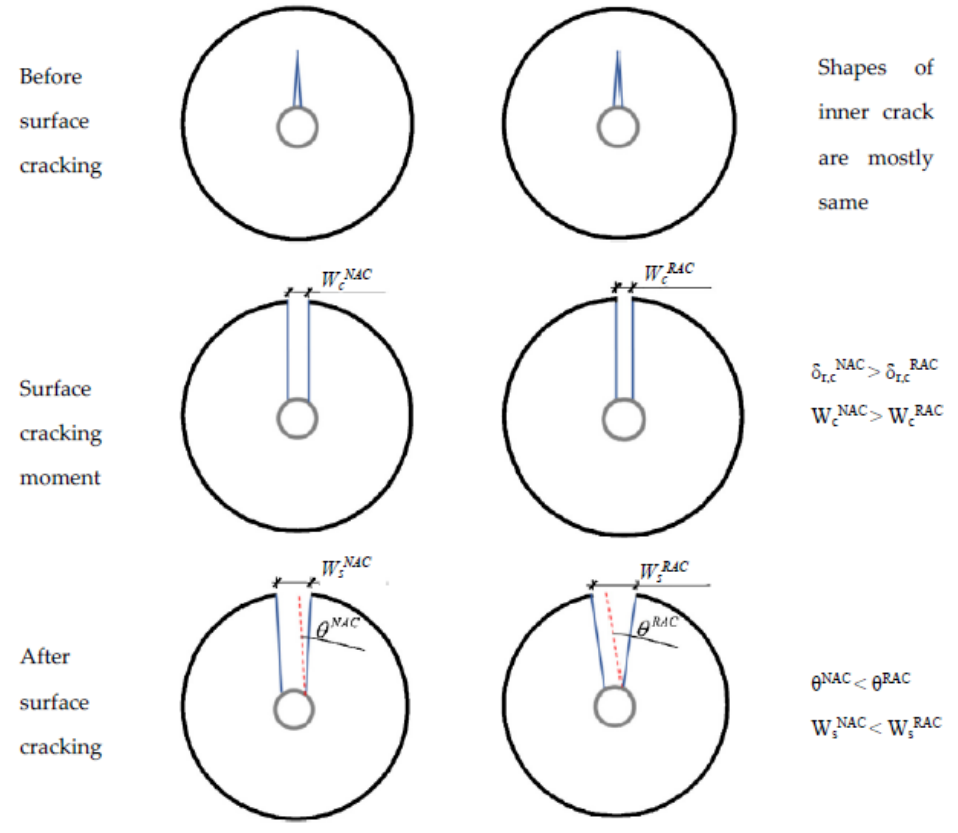
Figure 5. Propagation of corrosion-induced cracks in NAC ( left ) and RAC ( right ). Reproduced with permission from Ref. [100]. 2015, Elsevier.